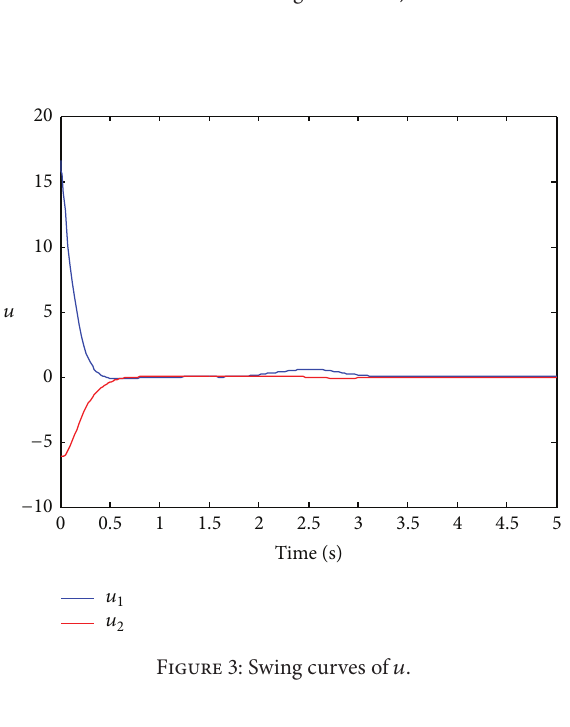
Figure 2: Swing curves of 𝜉 .